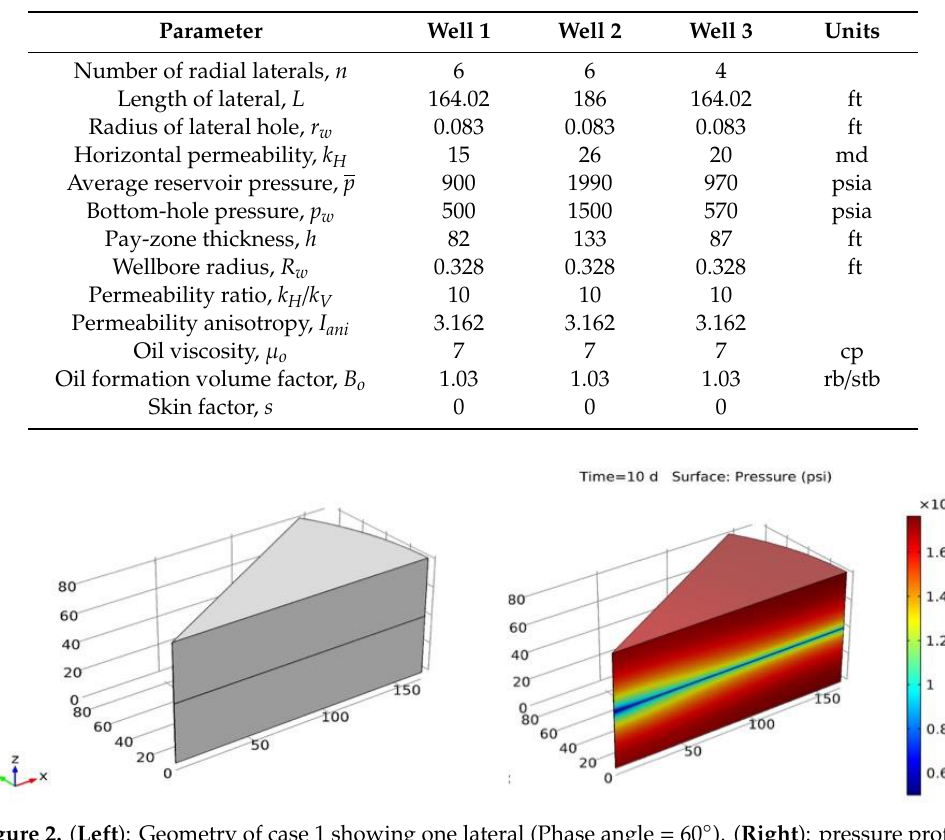
Table 1. Data for three wells in Belayim Land Oil Field, Egypt [8].